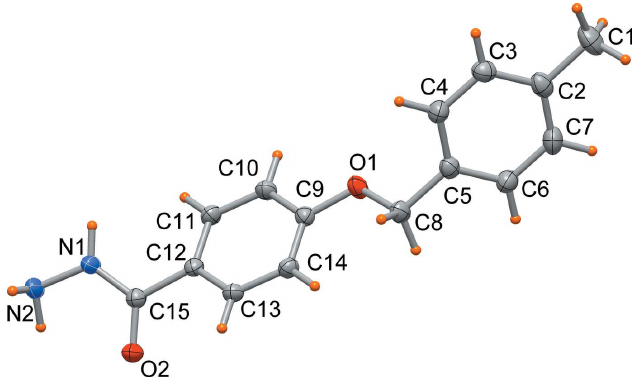
Figure 1 Molecular structure of (I), with displacement ellipsoids drawn at the 50% probability level.